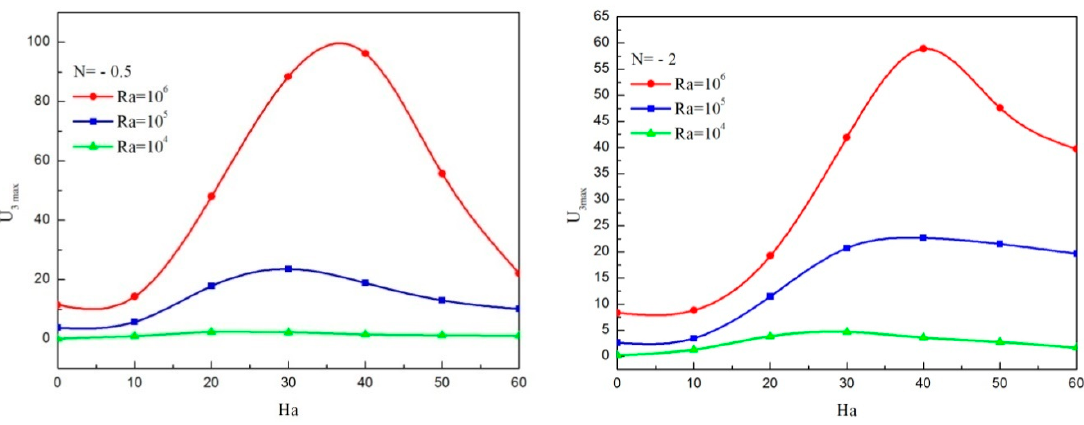
Figure 13. Variations of U 3max with Hartmann number for different Rayleigh number with φ = 4%, K = 1, N = − 0.5 and N = − 2.